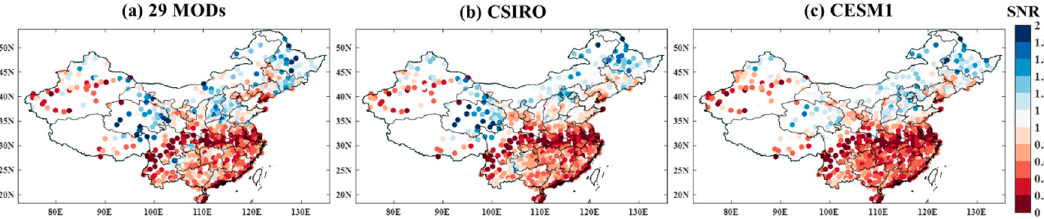
Figure 12. Spatial patterns of signal to noise ratio (SNR) for changes of 30-year drought frequency in the near future relative to the reference period over 659 stations in China. ( a ) 29 climate models; ( b ) 10-member CSIRO; ( c ) 40-member CESM1.